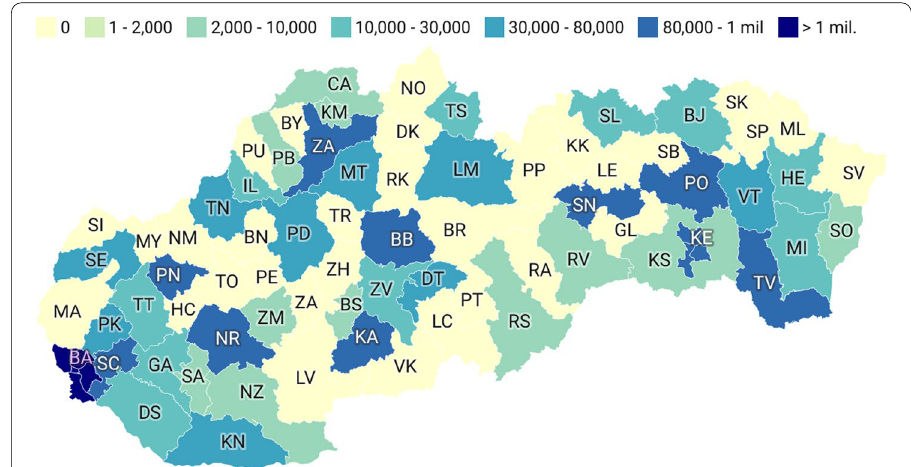
Table 1 Motives for participation and perceived impacts of the scheme Firm